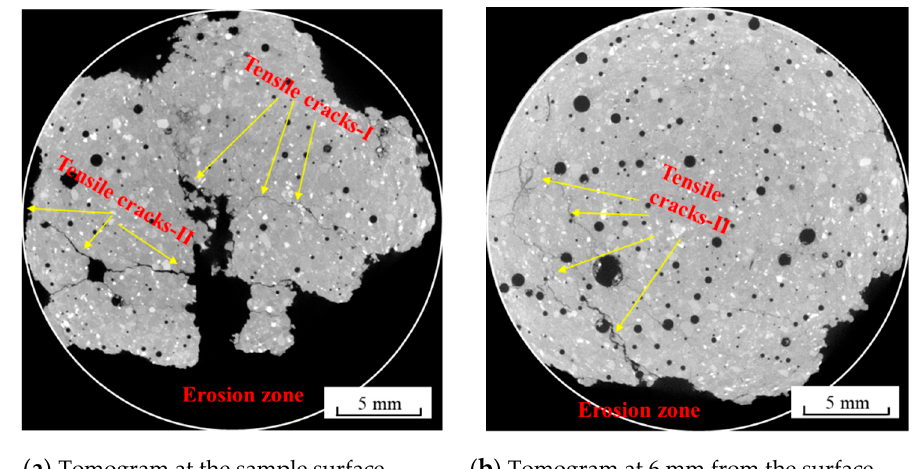
Figure 10. Tomographic images of the sample.